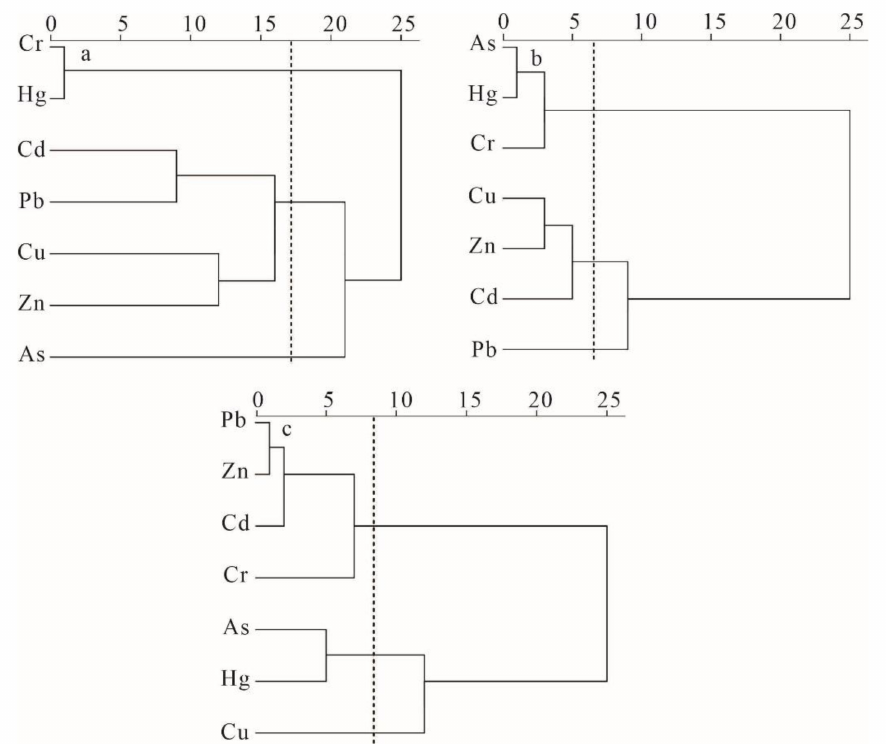
Figure 6. Dendrogram showing the clustering of the HMs in ( a ) ground water, ( b ) surface water, and ( c ) sediment